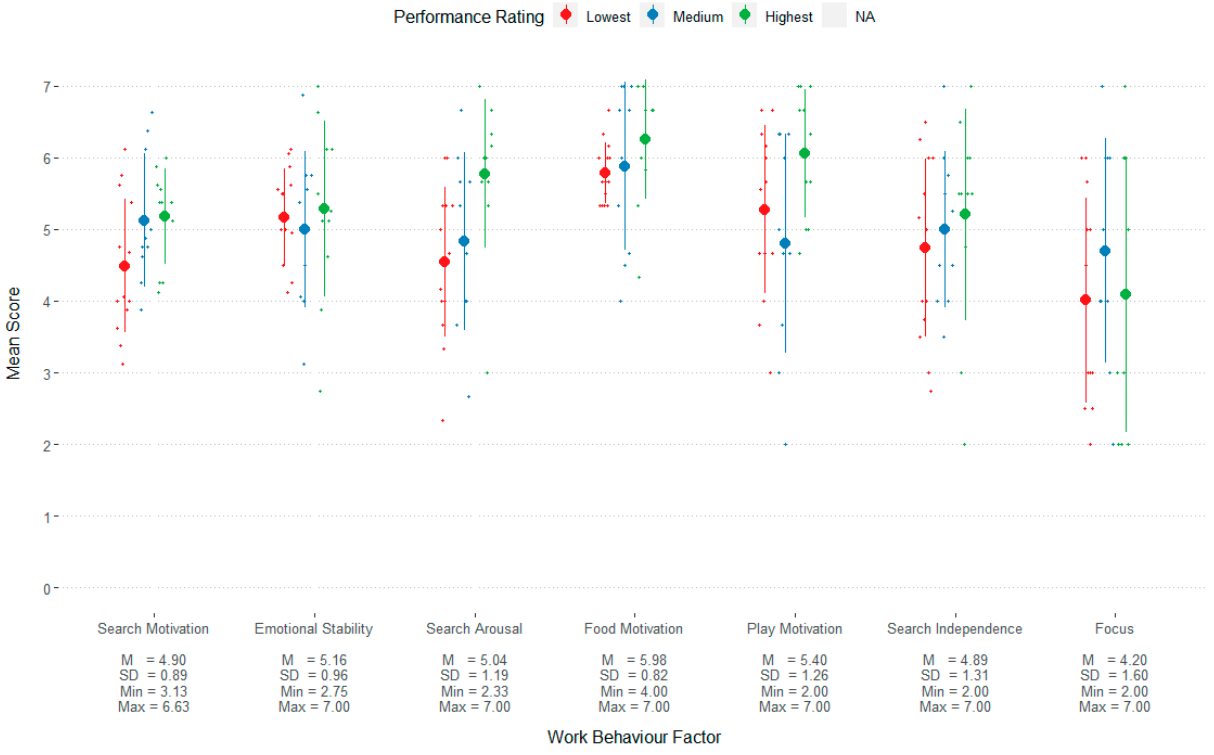
Figure 4. Scores of work behaviour dimensions for each group of performance rating. The circles indicate the mean and lines indicate the standard deviation. Each point is an individual dog’s score. For illustrative purposes, performance ratings groups were determined from the dogs’ overall performance rating scores allocated into three equal groups of the lowest, middle, and highest ratings. Descriptive statistics are presented below each factor